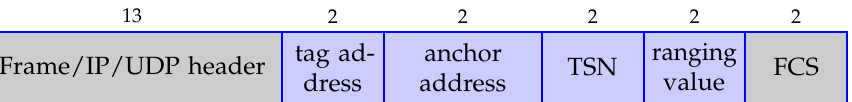
Figure 6. Structure of a ranging